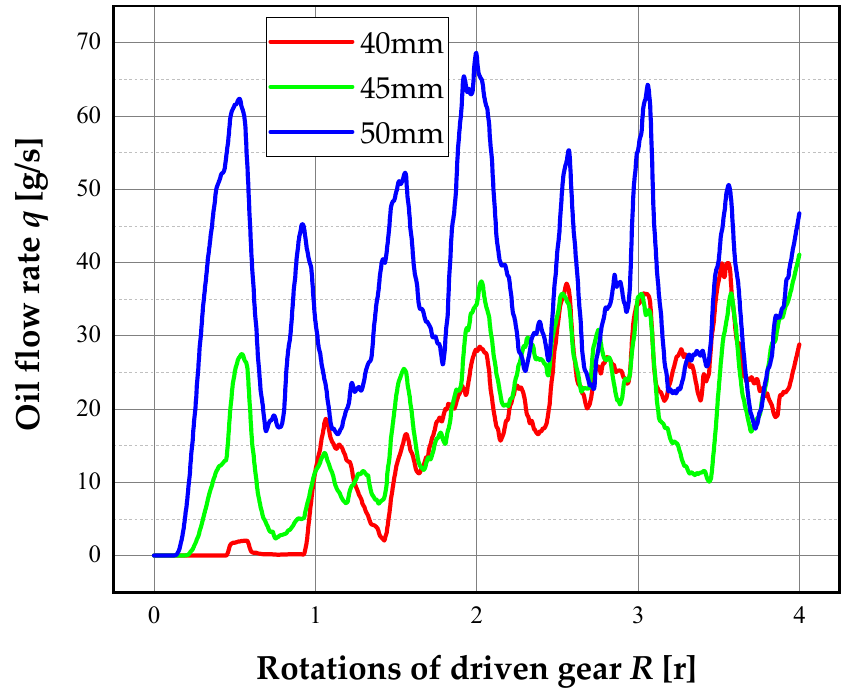
Figure 13. Oil flow rate of the meshing area at various oil-immersion depths.